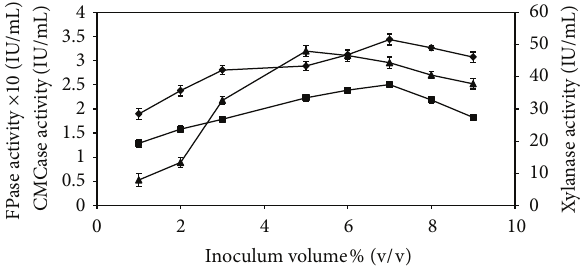
Figure 6: Effect of inoculum volume on CMCase, FPase, and xylanase activities. Results are presented as the mean of three replicates with standard deviation: ( Q ) FPase; ( ◼ ) CMCase; ( 󳵳 ) xylanase.